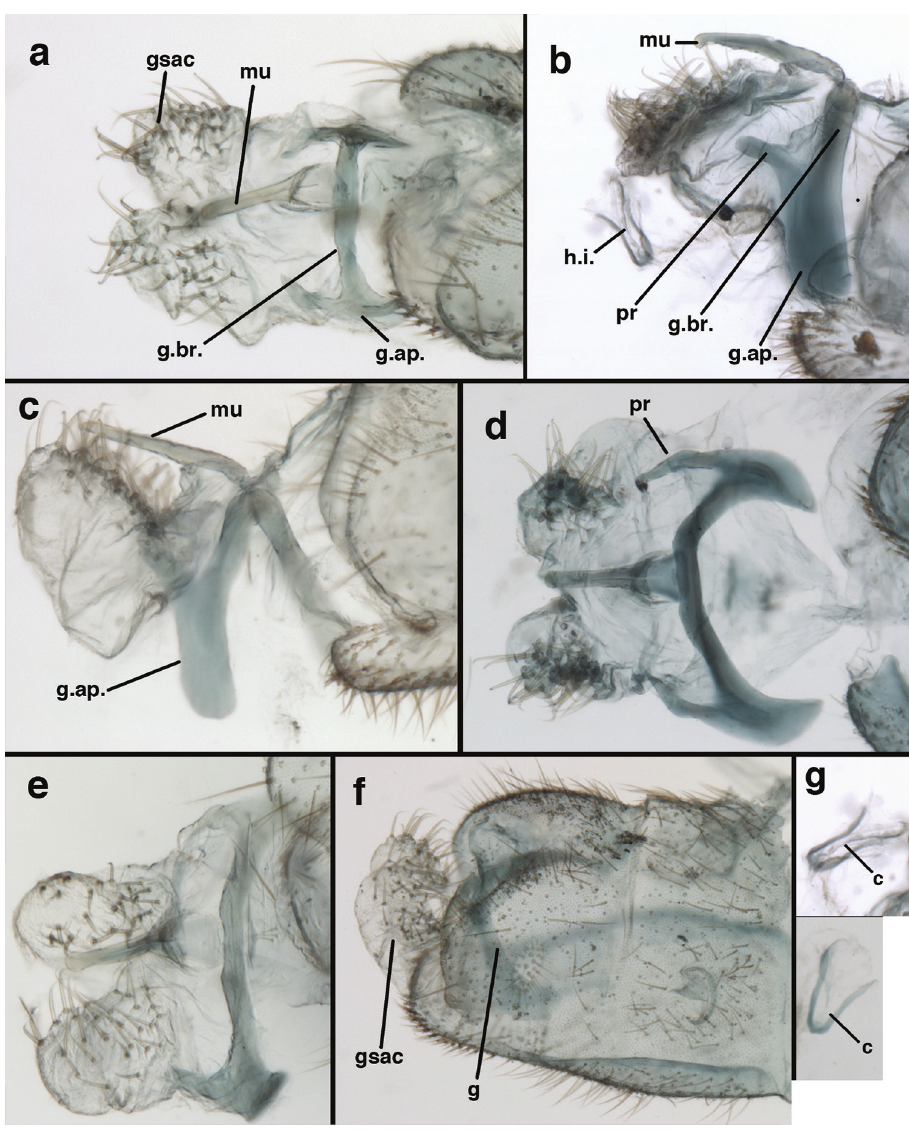
Figure 119. Ungla chacranella (Banks): Male genitalia, ( a ) gonarcal complex, dorsal ( b ) gonarcal com- plex, lateral, gonosaccus not fully expanded ( c ) gonarcal complex, posterolateral ( d ) gonarcal complex, posterodorsal ( e ) gonarcal complex, dorsal, gonosaccus fully expanded ( f ) terminal abdominal segments, dorsolateral, gonosaccus expanded, everted, gonarcus not everted ( g ) hypandrium internum (upper: slight- ly teneral, lower: mature). c comes g gonarcus gsac gonosaccus g.ap. gonarcal apodeme g.br. gonarcal bridge h.i. hypandrium internum mu mediuncus pr unarticulated process on frontal margin of gonarcal apodeme (Argentina; a, c, e, f, g-upper Salta, FSCA; b, d La Rioja, FSCA; g-lower Mendoza,